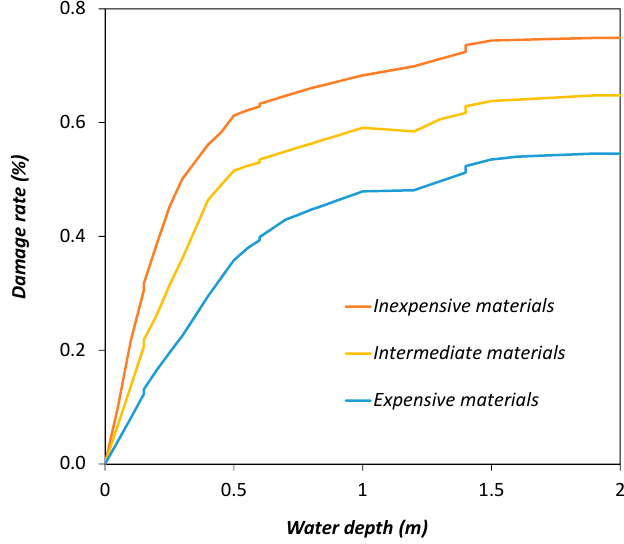
Figure 6. Damage related to water depth for buildings (adapted from [21]).